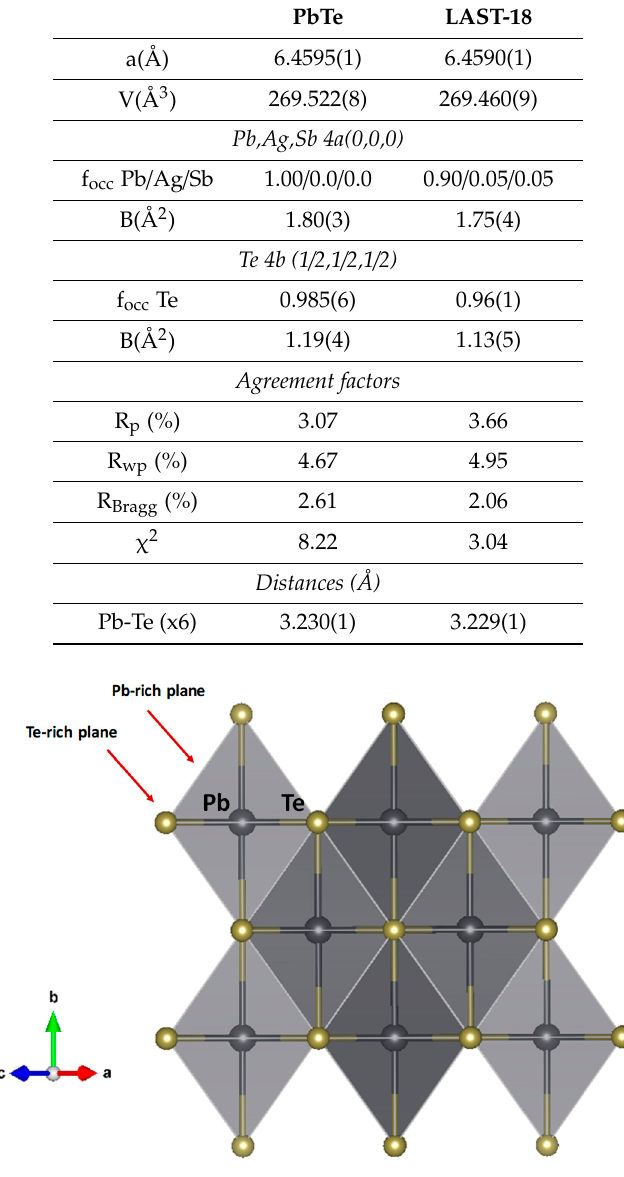
Figure 2. Crystal structure of PbTe along [110] directions, highlighting Te-rich planes alternating with Pb-rich planes.